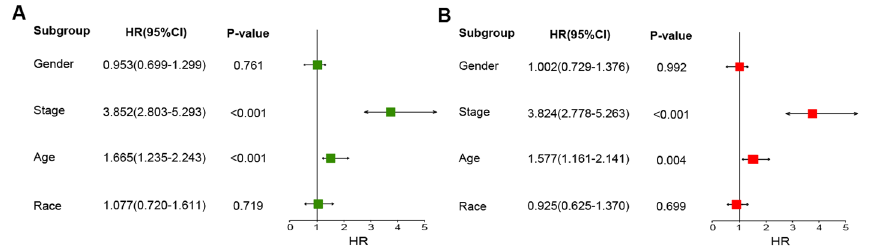
Figure 3. Stage and age were significantly associated with OS in KIRC patients. ( A ) Univariate Cox regression analysis of correlations between OS and clinical variables. ( B ) Multivariate Cox regression analysis of correlations between OS and clinical